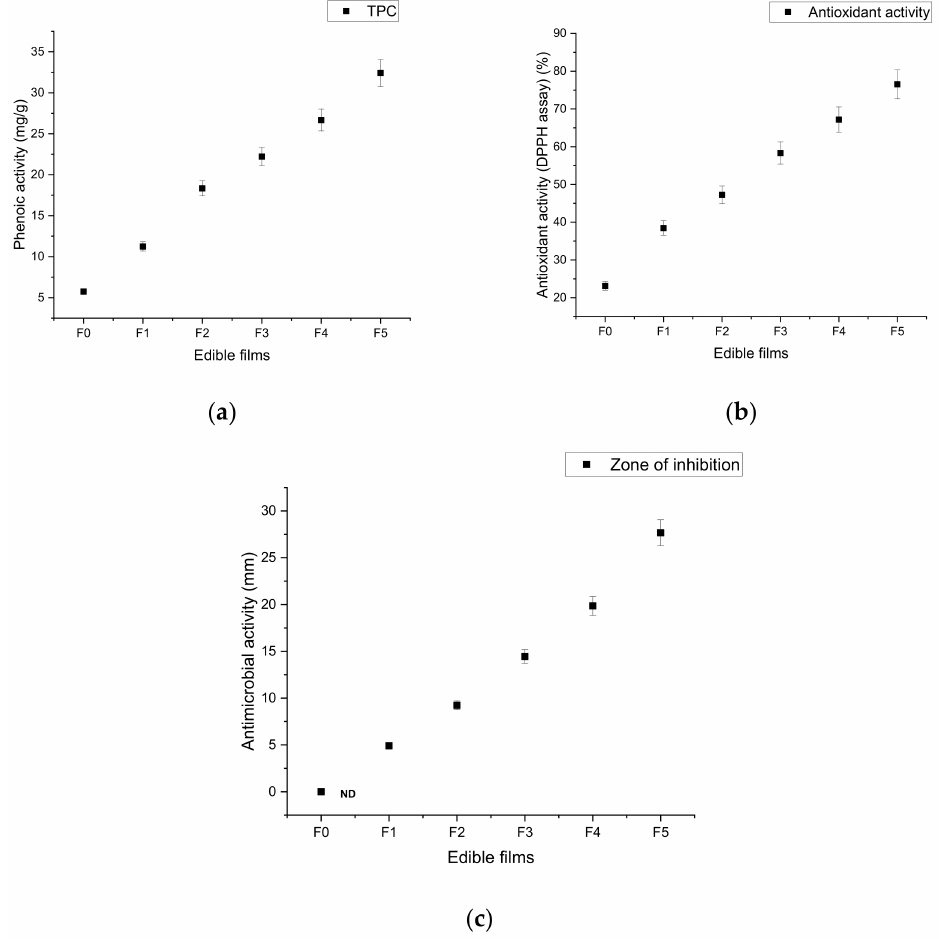
Figure 6. Effect of pomegranate peel extract on total phenolic content ( a ), antioxidant activity ( b ), and antimicrobial activity ( c ) of chitosan-based edible films. F0 = control (chitosan), F1 = 0.2 g/mL PGP, F2 = 0.4 g/mL PGP, F3 = 0.6 g/mL PGP, F4 = 0.8 g/mL PGP, and F5 = 0.10 g/mL